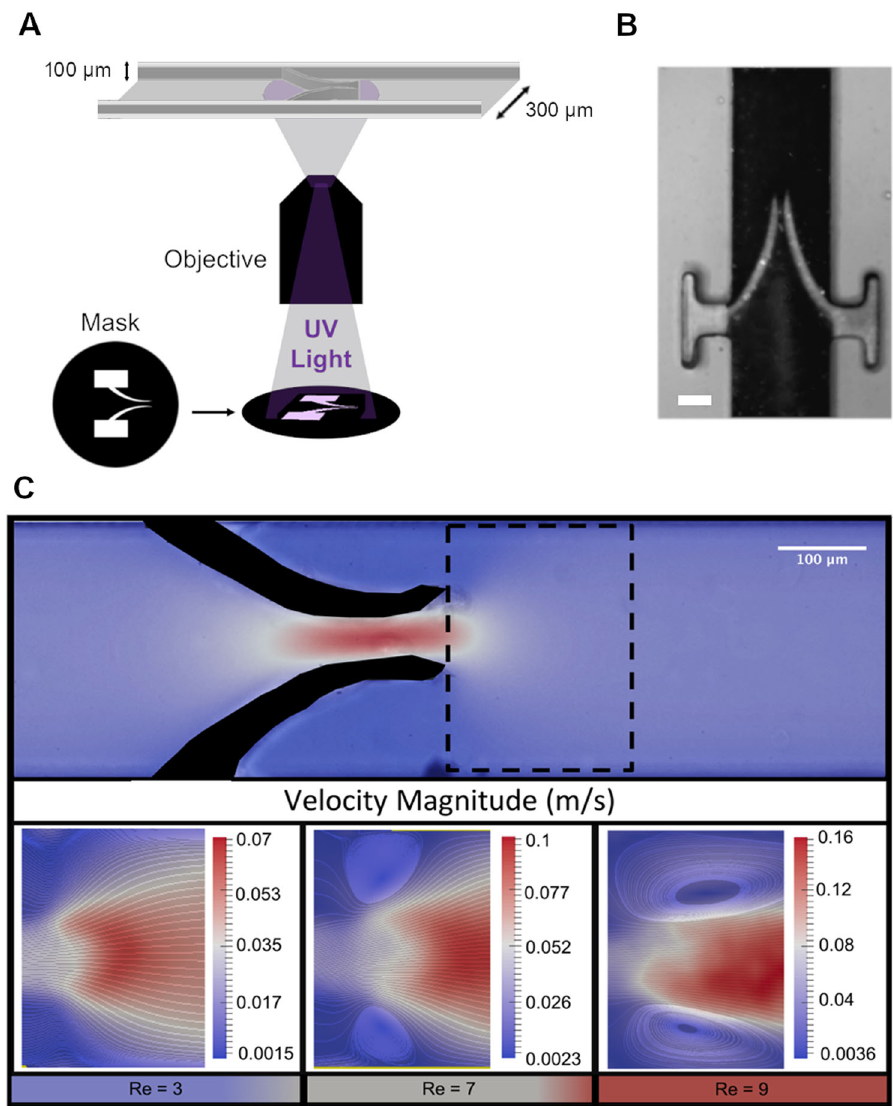
Fig. 1 Vortex formation in the presence of fl exible valves. a A Schematic diagram of mask alignment through the fl uorescent light of an inverted microscope. The mask was designed in order to produce the desired valve size through a 20× objective. b Optical image of the fl exible valve obtained. The length of the valve is about 330 µ m, the width of each lea fl et starts at about 45 µ m and it tapers towards the tip. The initial gap in between the lea fl ets when there is no fl ow is about 30 µ m. The scale bar represents 100 µ m. c The top image is a velocity pro fi le map with the site of vortex formation at the tip of the valve designated by the dashed line. Images below (from left to right) represent the vortex getting larger with increased fl ow rate (valve properties: 2% w/v [PI] and 40% w/v